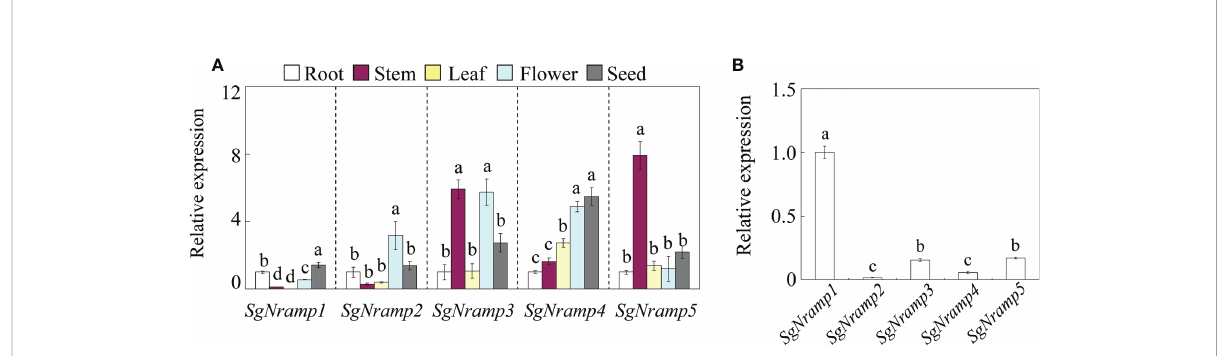
FIGURE 3 Expression analysis of SgNramps in various tissues. (A) Expressions of SgNramps in root, stem, leaf, fl ower, and seed. The expression of each gene in the roots was set to one, and then the expression level of each gene in other tissues was normalized to its expression in the roots. (B) Expressions of SgNramps in stylo root. The expression of SgNramp1 was set to one, and then the expression level of the other SgNramps was normalized to SgNramp1 . Data are means of three biological replicates with standard error (SE). Different letters represent signi fi cant differences among various tissue (A) or SgNramp genes (B) at P <